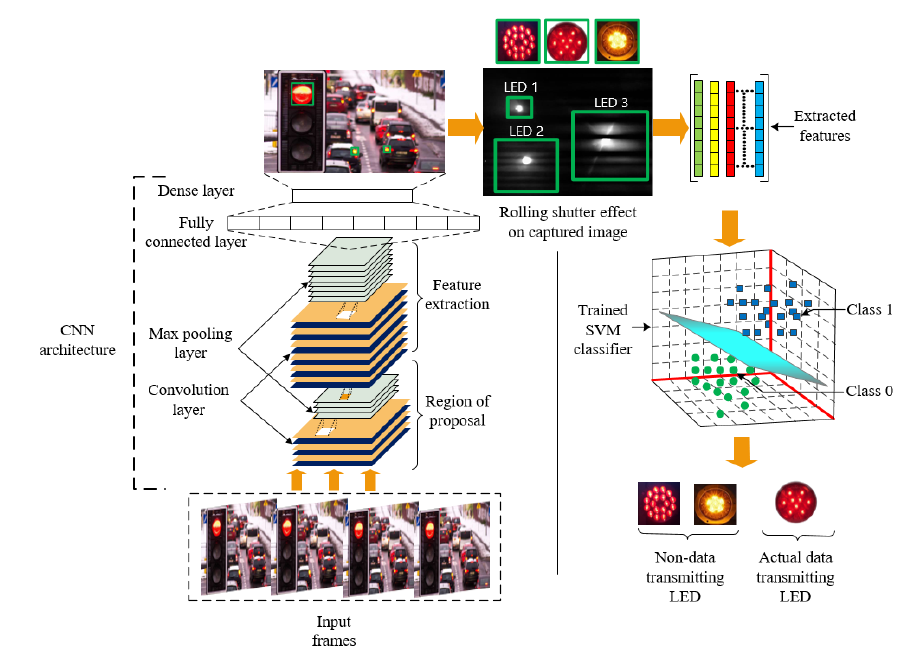
Figure 5. Workflow inside the proposed intelligent OCC